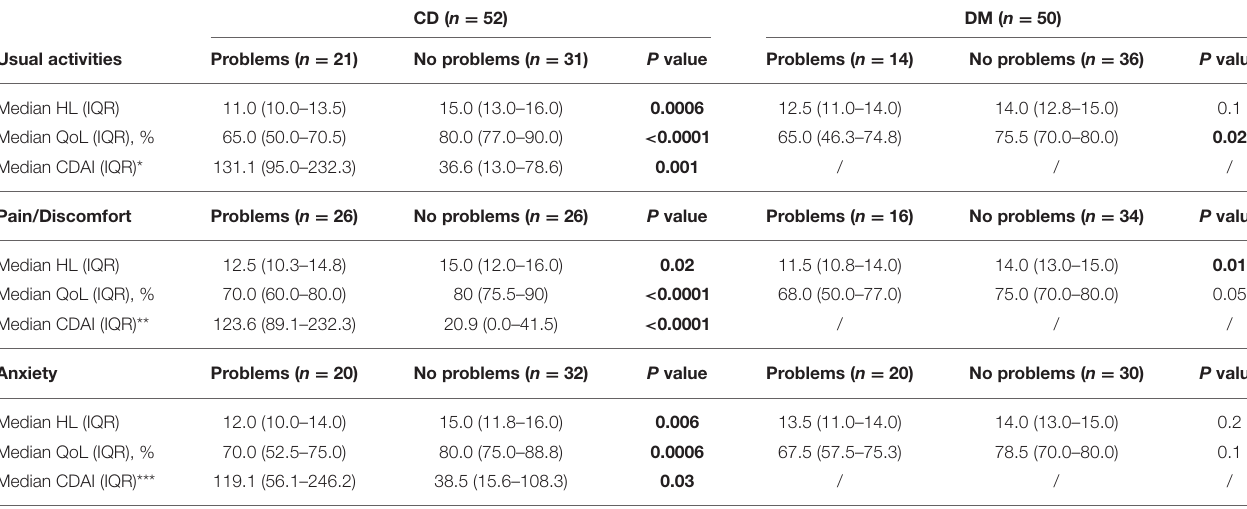
* Data for 20CD patients with problems (1 missing). ** Data for 25CD patients with problems (1 missing). *** Data for 19CD patients with problems (1 missing). CD, Crohn’s Disease; CDAI, Crohn’s Disease Activity Index; DM, Diabetes Mellitus; HL, Health Literacy; IQR, Interquartile Range; QoL, Quality of Life. Statistically significant values in